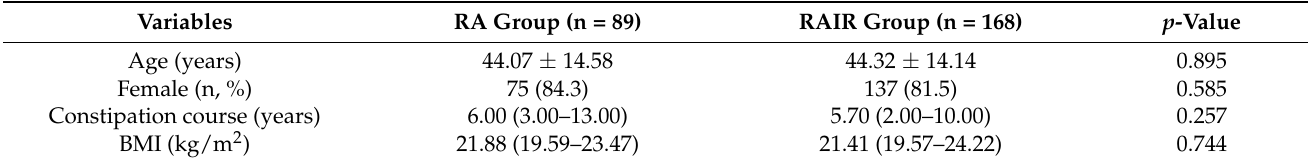
Table 1. Baseline data after the PSM analysis.